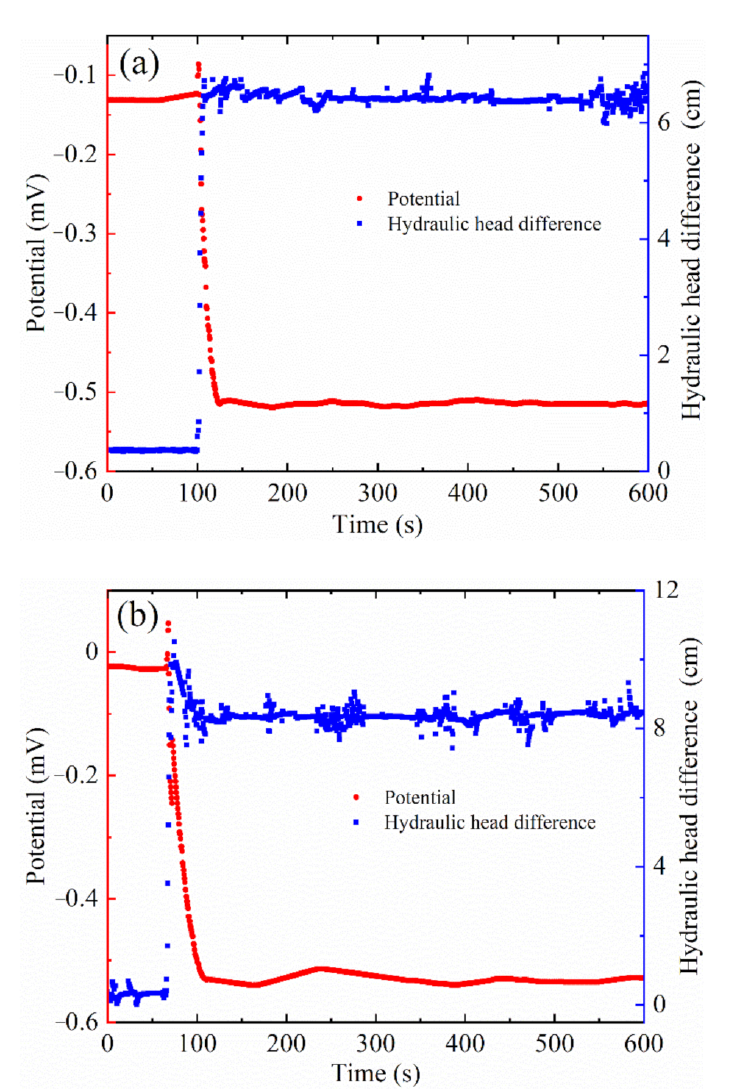
Figure 5. The change of potential and hydraulic head difference at different water levels when the compactness is 85% and the concentration is 0.01 M. ( a ) 20 cm hydraulic head. ( b ) 40 cm hydraulic head. The red circle symbols represent the potential, and the blue square symbols represent the hydraulic head